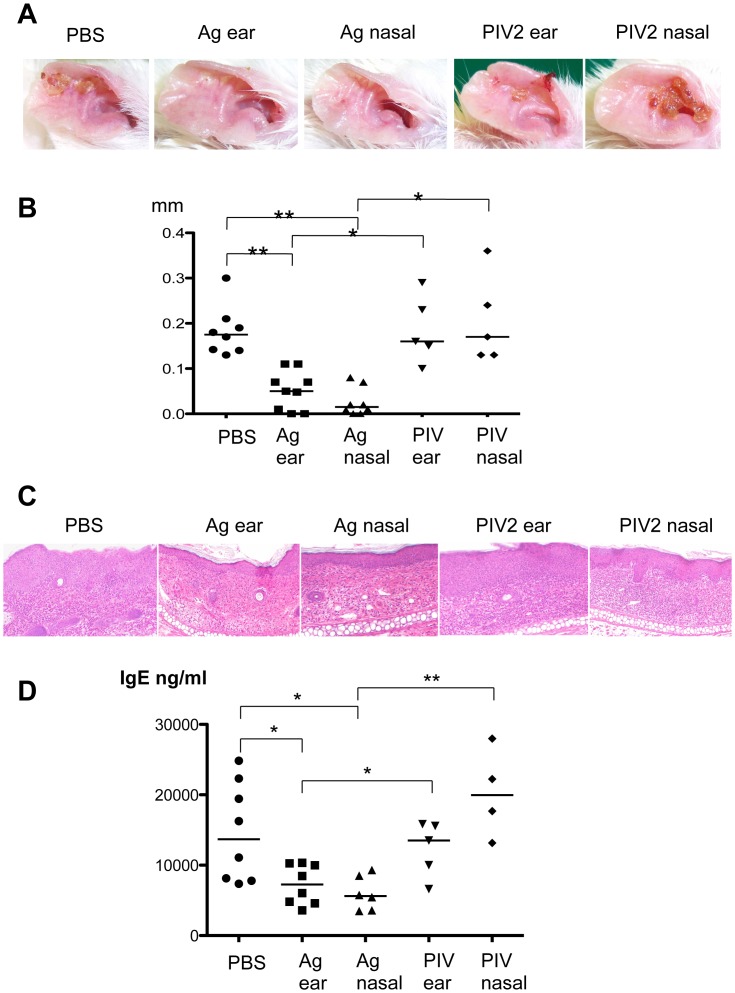
Anti-inflammatory effects of vaccination with rhPIV2/Ag85B.
A. Clinical manifestation of the ear skin at 6 hours after OX challenge on day 21. The control groups (PBS, PIV2 ear, and PIV2 nasal on the panel) showed severe edema with erythema, however the intranasal and/or subcutaneous administration of the rhPIV2/Ag85B (Ag nasal and Ag ear on the panel, respectively) clearly reduced skin reactions in OX-sensitized mice. B. Ear thickness measured before and 6 hours after each OX application on day 21. The ear swelling was suppressed significantly in rhPIV2/Ag85B treated groups in two ways compared to those in the placebo treated groups. (*P<0.05, **P<0.01.) C. Histopathological changes of the ear skin obtained on day 21 in paraffin embedded sections stained with hematoxylin and eosin. The placebo treated groups (PBS, PIV2 ear and PIV2 nasal on the panel) revealed marked inflammatory reactions with acanthosis and ulceration in epidermis, and marked edema with cellular infiltration including mononuclear cells and neutrophils in the dermis. The skin infiltration of inflammatory cells and epidermal thickness were decreased in rhPIV2/Ag85B treated group (Ag85B ear and Ag85B nasal on the panel). Original magnification × 100. D. Plasma IgE levels on day 21. Plasma IgE level was decreased in rhPIV2/Ag85B treated groups (Ag ear and Ag nasal). *P<0.05, **P<0.01.